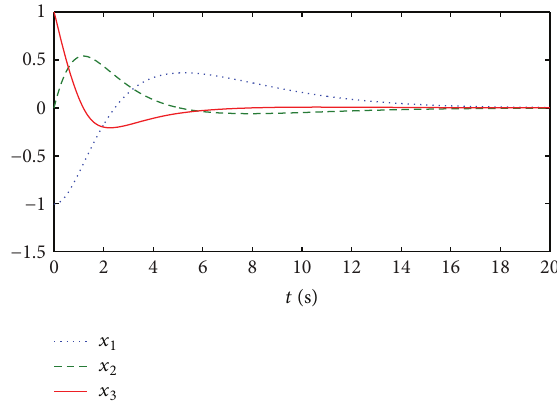
Figure 1: State 𝑥(𝑡) of the closed-loop system.